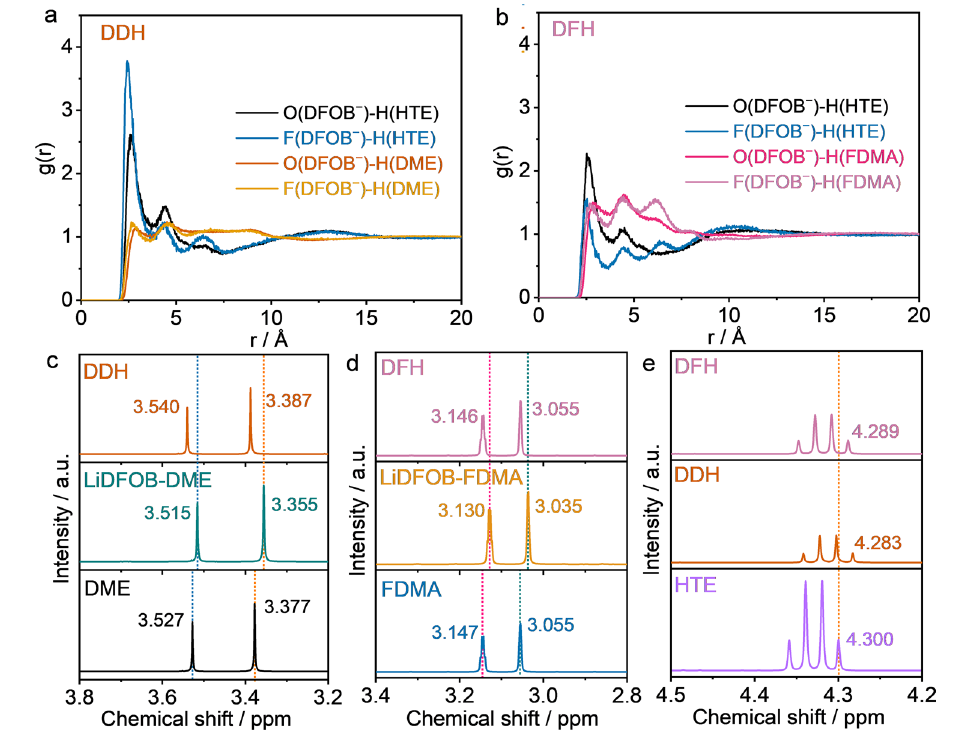
Fig. 1 Electrostatic effect between anion and solvents. Radial distribution function between anions and solvent/diluent molecule in a DDH and b DFH electrolytes. 1 H NMR spectra of c pure DME solvent, LiDFOB-DME and DDH electrolytes, d pure FDMA solvent, LiDFOB-FDMA and DFH electrolytes, and e pure HTE solvent, DDH and DFH